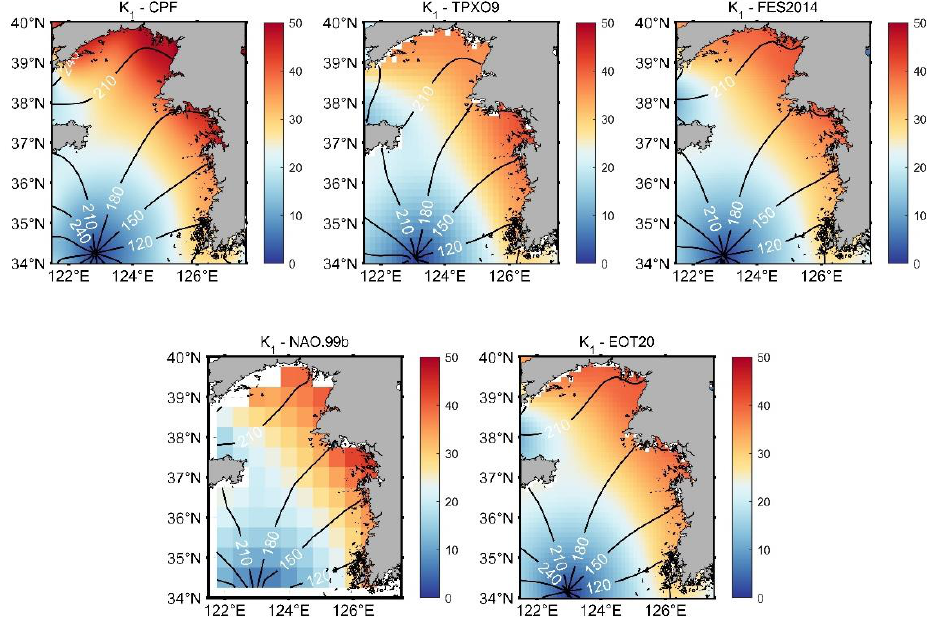
Figure 7. The cotidal charts of the K 1 constituent from the CPF method and the TPXO9, FES2014, NAO.99b and EOT20 models (unit: cm).